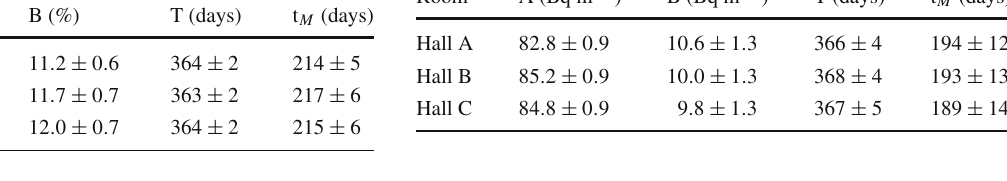
Table 3 Values of the fitted parameters of the relative humidity of the years 2013–2018 to Eq. (2). The maxima are in the first week of August Room